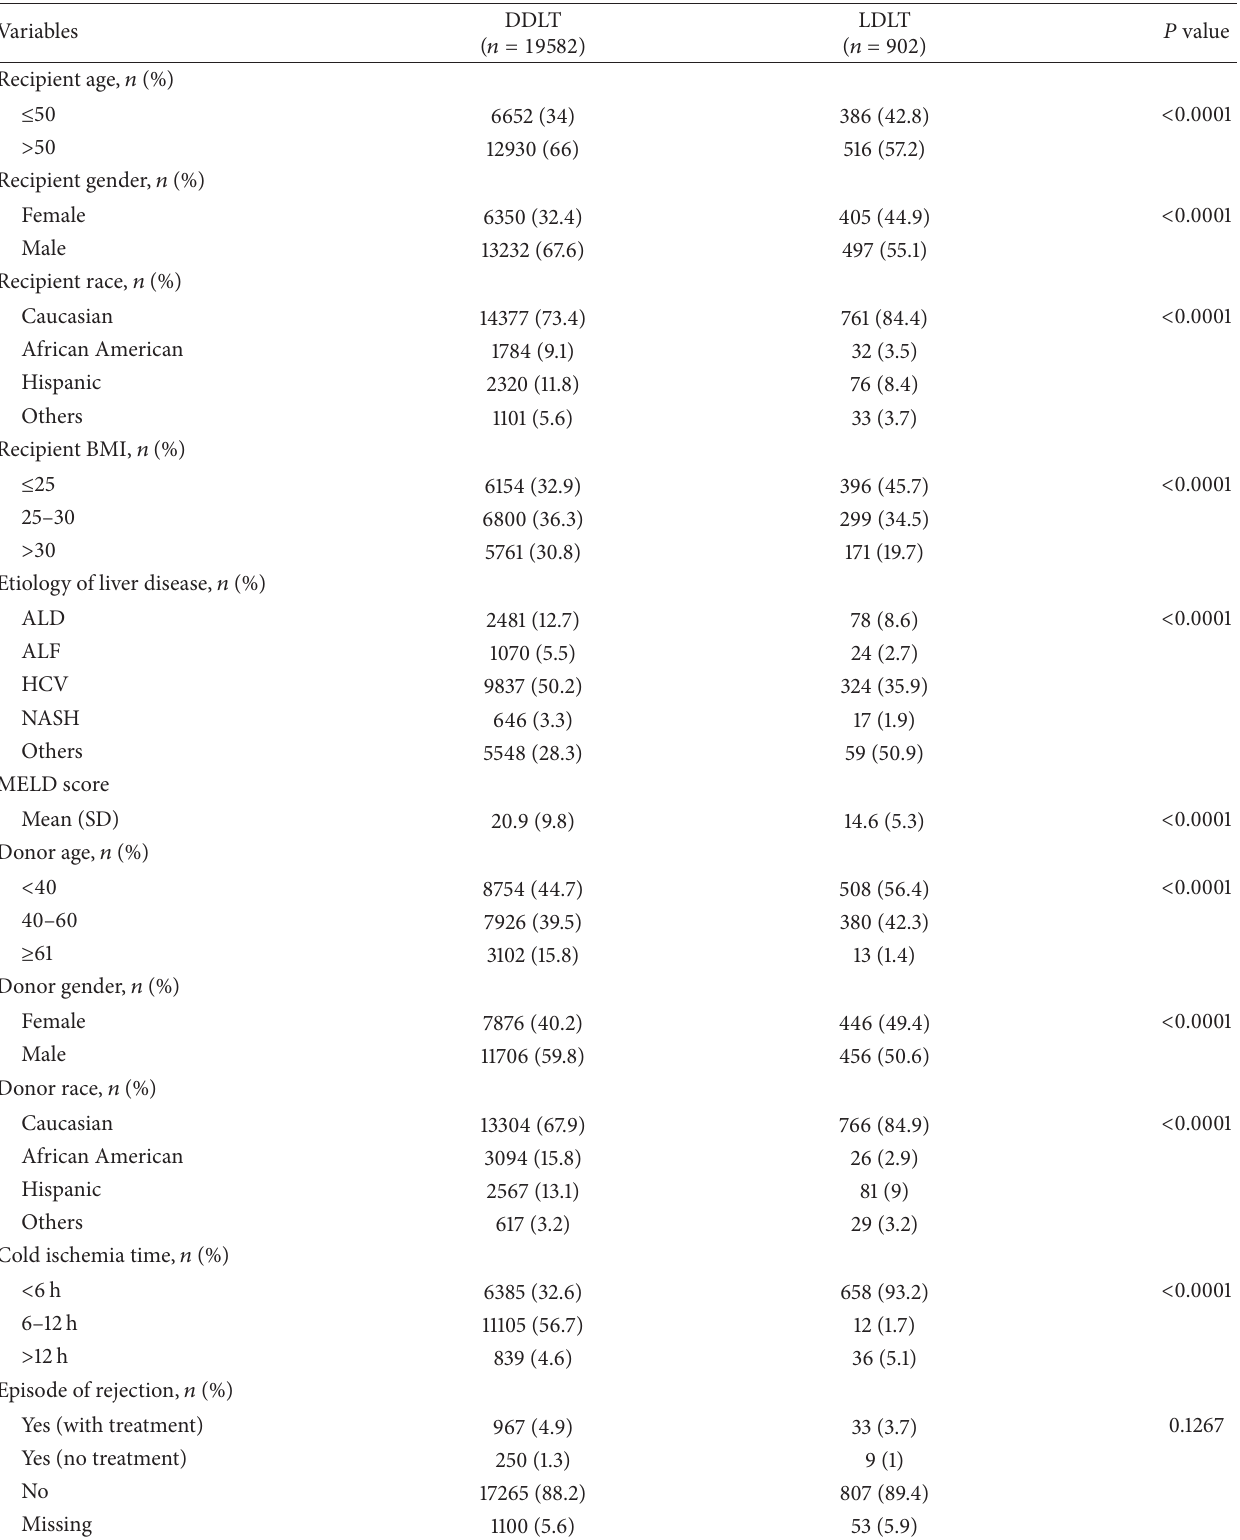
Table 1: Baseline demographic statistics for DDLT and LDLT